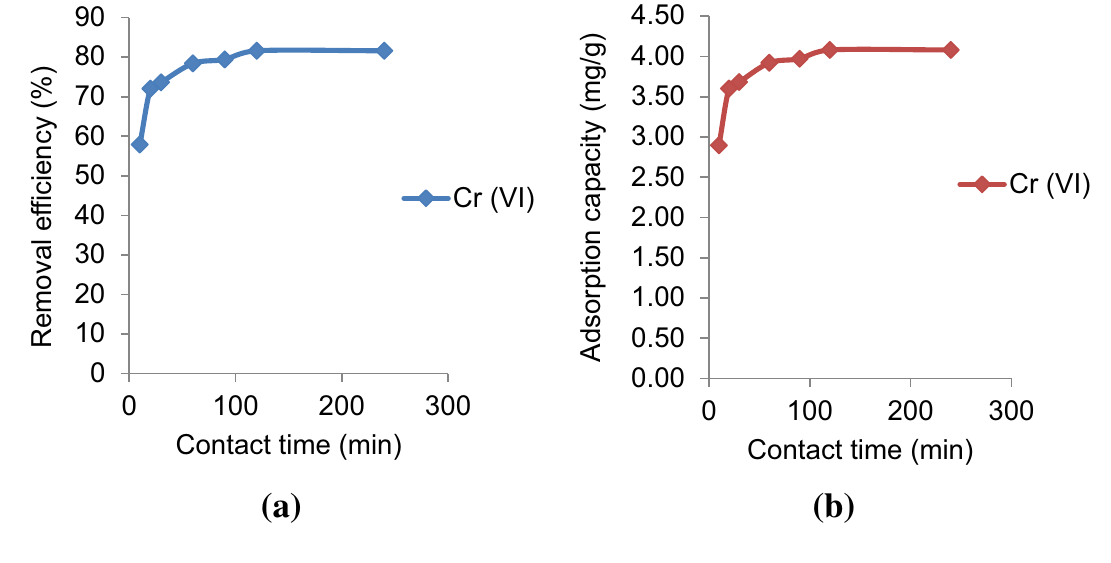
Fig. 2 Effect of contact time on the adsorption of Cr(VI)